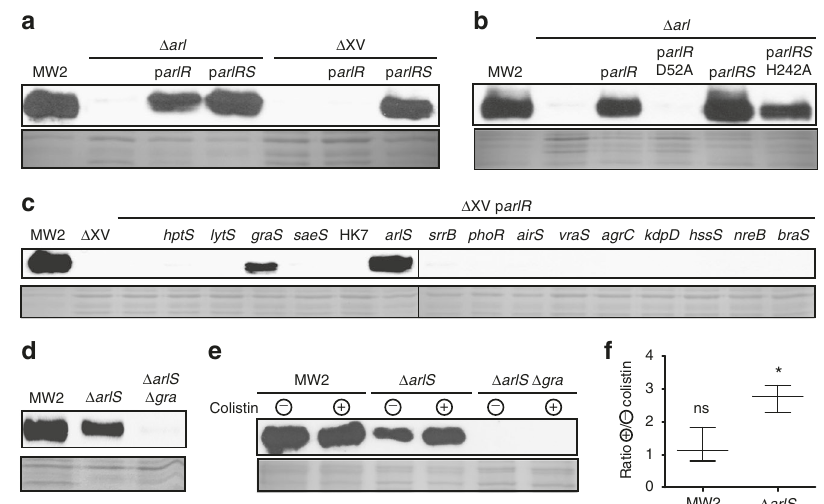
Fig. 6 In vivo cross-talk analysis. Protein A expression in CDM was detected by western blotting on the following strains (full blots and gels are shown in Supplementary Fig. 10): a Δ arl and Δ XV strains, both complemented with arlR and arlRS ; b Δ arl strain complemented with arlR , arlR (D52A), arlRS , and arlRS (H242A); c Δ XV strain complemented with the set of plasmids containing arlR combined with the 15 HKs; d MW2, Δ arlS and Δ arlS Δ gra strains; and e MW2, Δ arlS and Δ arlS Δ gra strains, in the presence or absence of colistin. It is known that colistin induces the activation of GraS. Coomassie-stained gels or Ponceau-stained membranes are shown as a loading control in all sections. f Densitometry quanti fi cation of the protein A western blotting bands. Ratios of protein A band intensity from MW2 and Δ arlS strains growing in the presence or absence of colistin were represented. Average and SD of three independent assays were recorded. Data were compared using two-tailed one-sample t -test inferred from a hypothetical value of 1 ( n = 3, ns = no signi fi cant difference; * p <